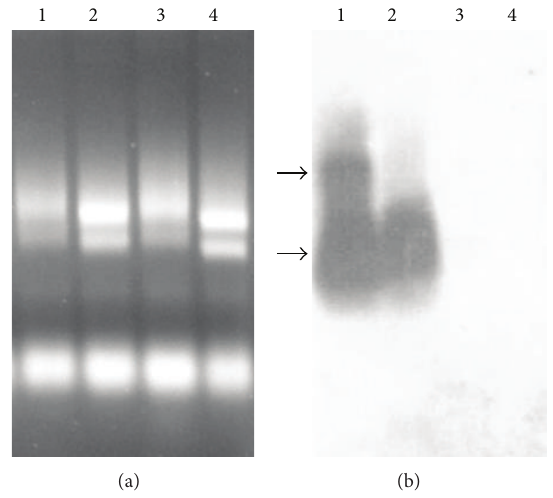
Figure 4: Northern blot analysis of EGFR expression. (a) Total RNA (20 𝜇 g) was loaded on a formaldehyde 1.5% agarose gel. RNA was extracted from E. coli BL21 cells transformed with pGEX-EGFR after one-hour induction with 0.1 mM IPTG (lane 1) or without induction (lane 2). Extracted RNA of E. coli BL21 cells transformed with empty pGEX-6P-1 after one-hour induction with 0.1 mM IPTG (lane 3) or withoutIPTGinduction(lane4)usedascontrol.(b)ThegelinAwas blotted on a nitrocellulose membrane and radioactive hybridization was performed with a 1.9kb PCR fragment of EGFR ECD